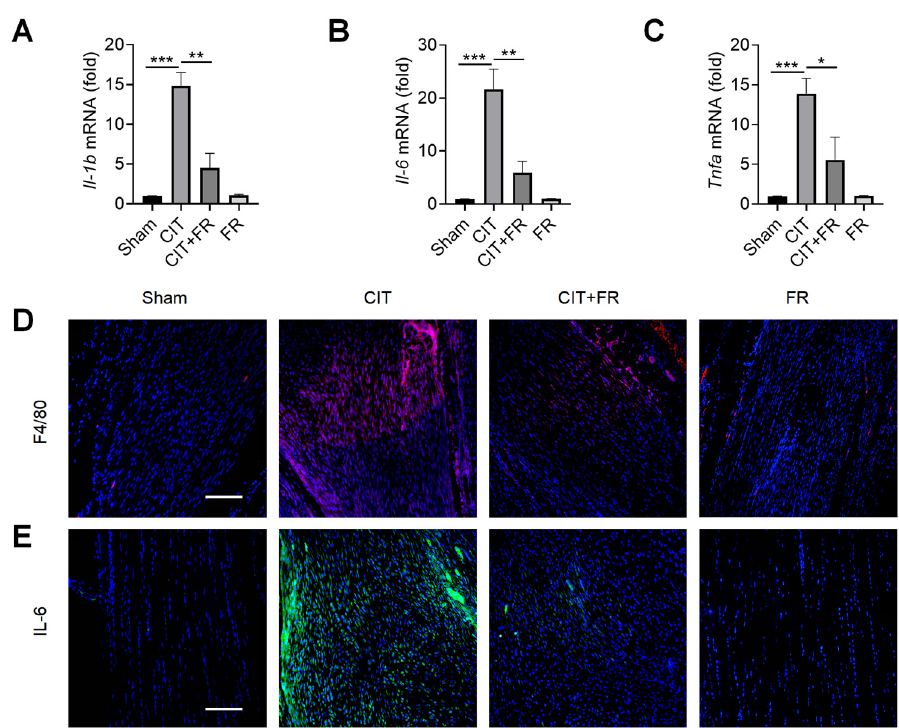
Figure 2. FR alleviates the inflammatory response of tendinopathy in mice. ( A – C ) Four weeks after treatment in mice, the effect of FR on the expression of inflammatory cytokine ( Il-1b , Il-6 , and Tnfa ) mRNA was detected by qRT-PCR. The expressions of macrophage marker F4/80 ( D ) and inflammatory factor IL-6 ( E ) were detected by immunofluorescence. Scale bar: 100 μ m. Data are expressed as the means ± SD from three independent experiments. * p < 0.05, ** p < 0.01, *** p < 0.001.